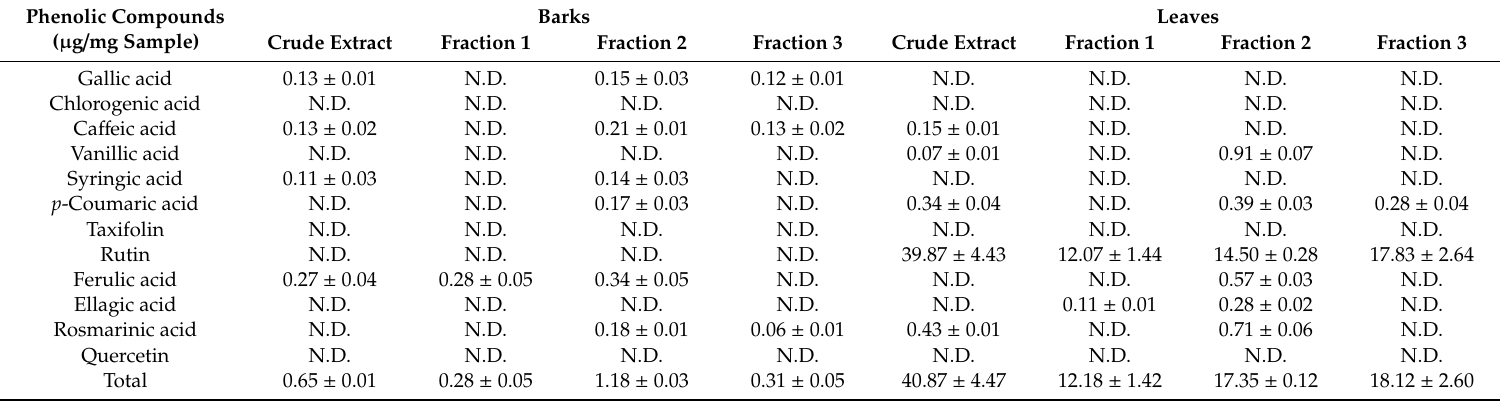
Table 3. Phenolic profile of P. angolensis ( n = 2; N.D. = not